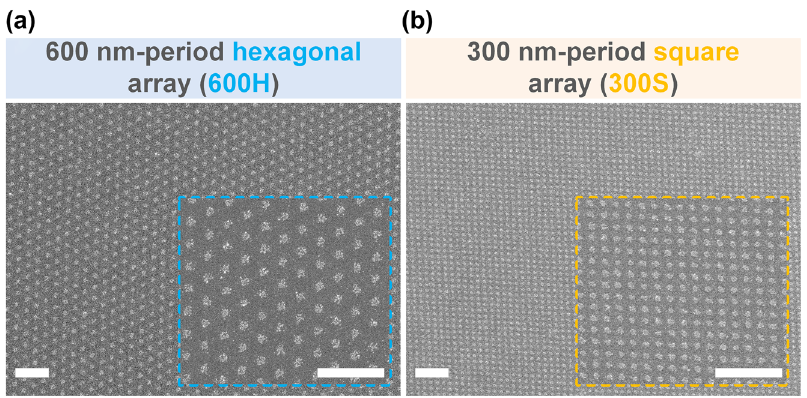
Figure 4: Various Ag nanodot patterns fabricated by soft NIL of the ionic Ag ink. SEM images of Ag nanodot structures with different scales and arrays: (a) 600-nm- period hexagonal array (600H) and (b) 300-nm-period square array (300S), with the corresponding inset images for enlarged views. All scale bars: 2 µm.